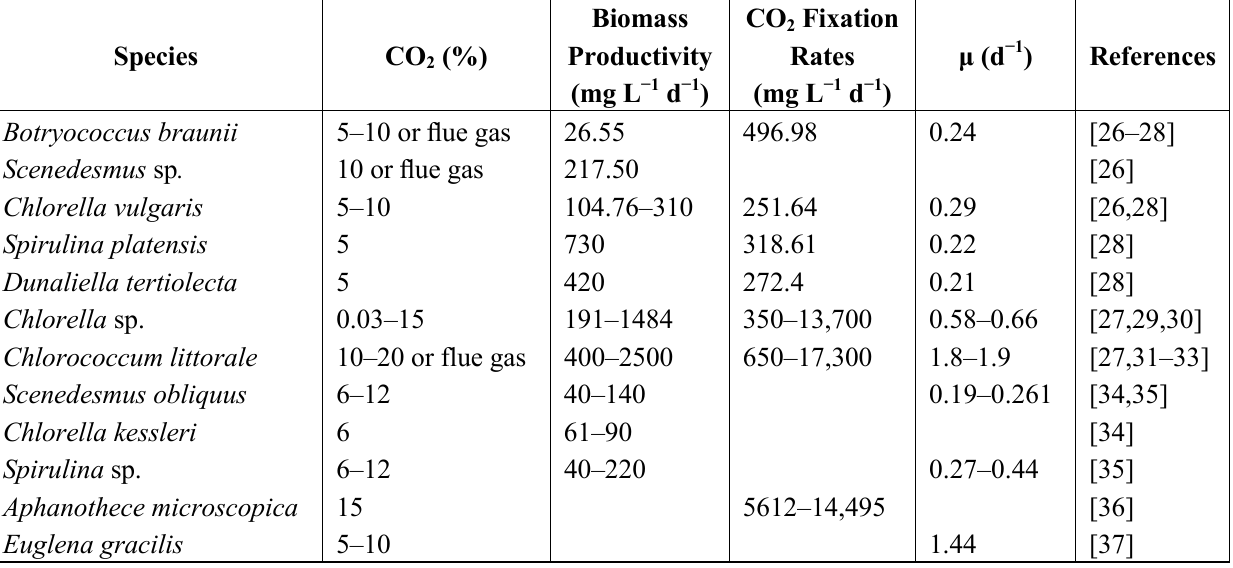
fixation and specific growth rates for different 2